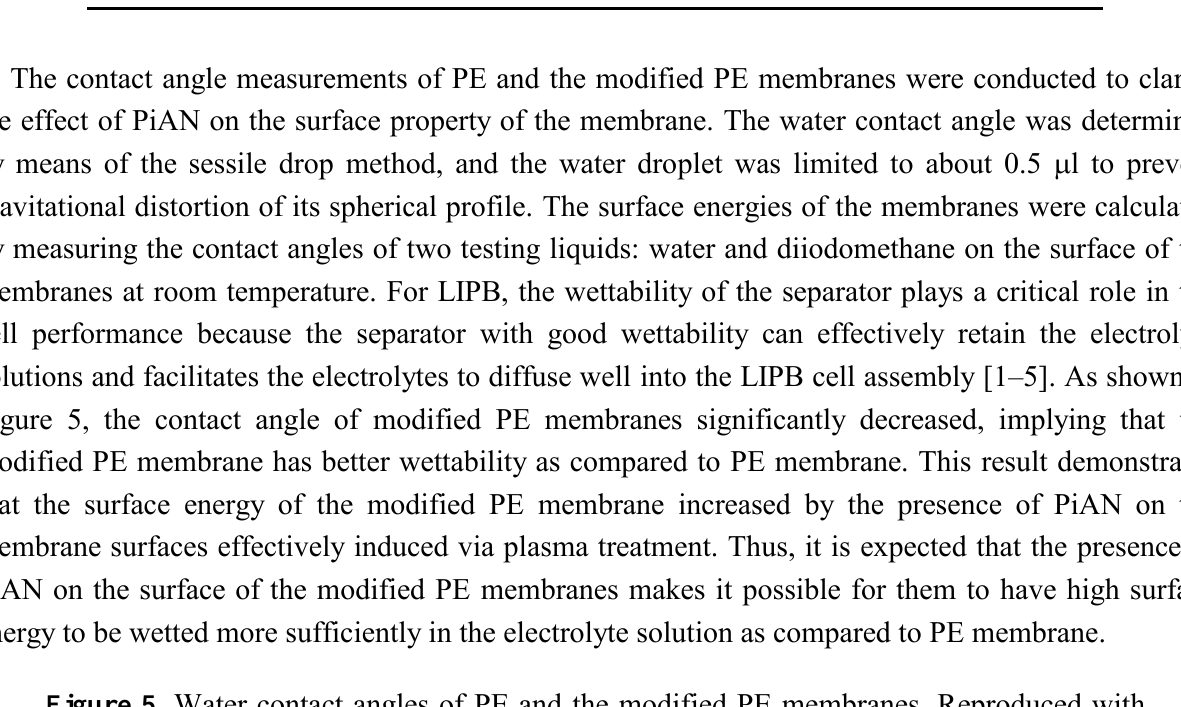
Figure 5. Water contact angles of PE and the modified PE membranes. Reproduced with permission from Reference [58]. © 2009 Elsevier